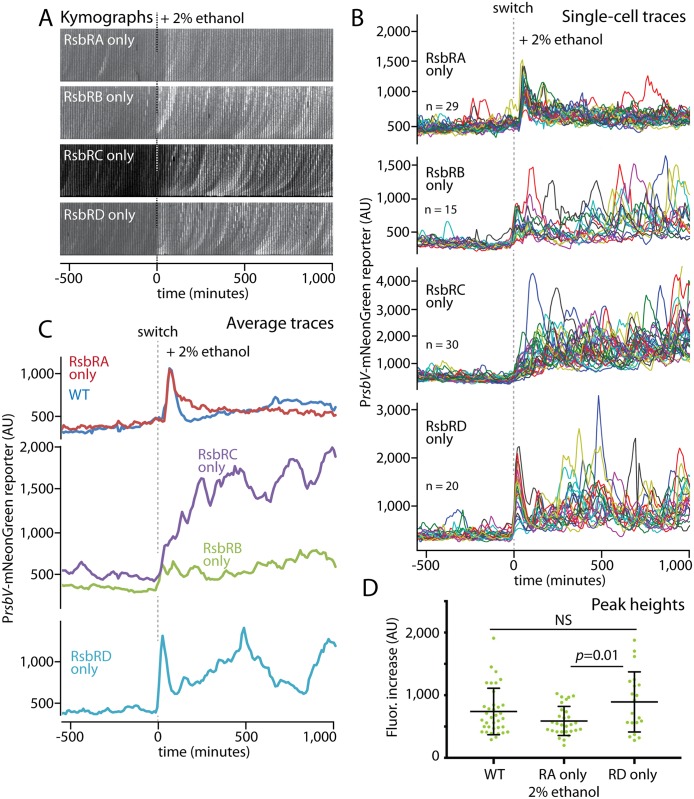
The four RsbR paralogs exhibit distinct response profiles in response to an identical stress.A. Kymographs of individual cell lineages of strains containing RsbRA, RsbRB, RsbRC, or RsbRD as the only RsbR in the cell (MTC1761, 1763, 1765, and 1767, respectively). Ethanol was added at t = 0 (dashed lines). B. Single-cell intensity traces of a stress-responsive PrsbV-mNeonGreen reporter the single-RsbR strains responding to the addition of 2% ethanol (dashed line). C. Average intensity traces of the cell populations shown in B, grouped to highlight similarities and differences. The traces were manually curated to eliminate cell lineages with cell-death events or other anomalies; comparisons of mean traces for curated and uncurated populations are shown in S4 Fig. D. Distributions of signal increases in single cells from before stress exposure to their maximal peak values; only strains showing a sharp and transient initial response were evaluated. NS, not significant.